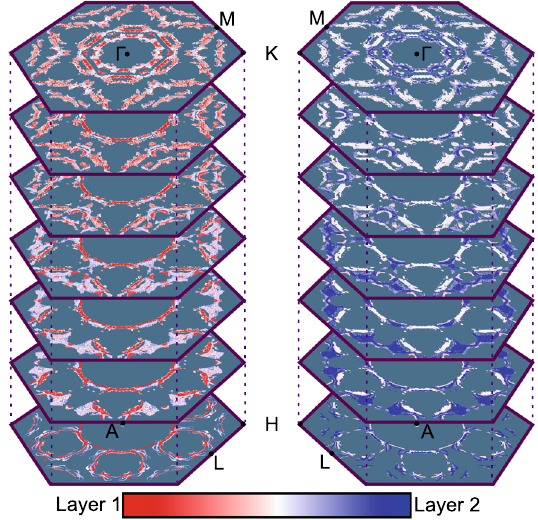
Fig. 4 Fermi surface projected on the structural layers. Slices of the unfolded Fermi surface computed at different values of k z (0.1 π thick), from k z = 0 (top) to k z = π / c (bottom), showing the projection of the electronic states onto the two structural layers L 1 and L 2 . States localized on L 1 (L 2 ) are highlighted in red (blue).